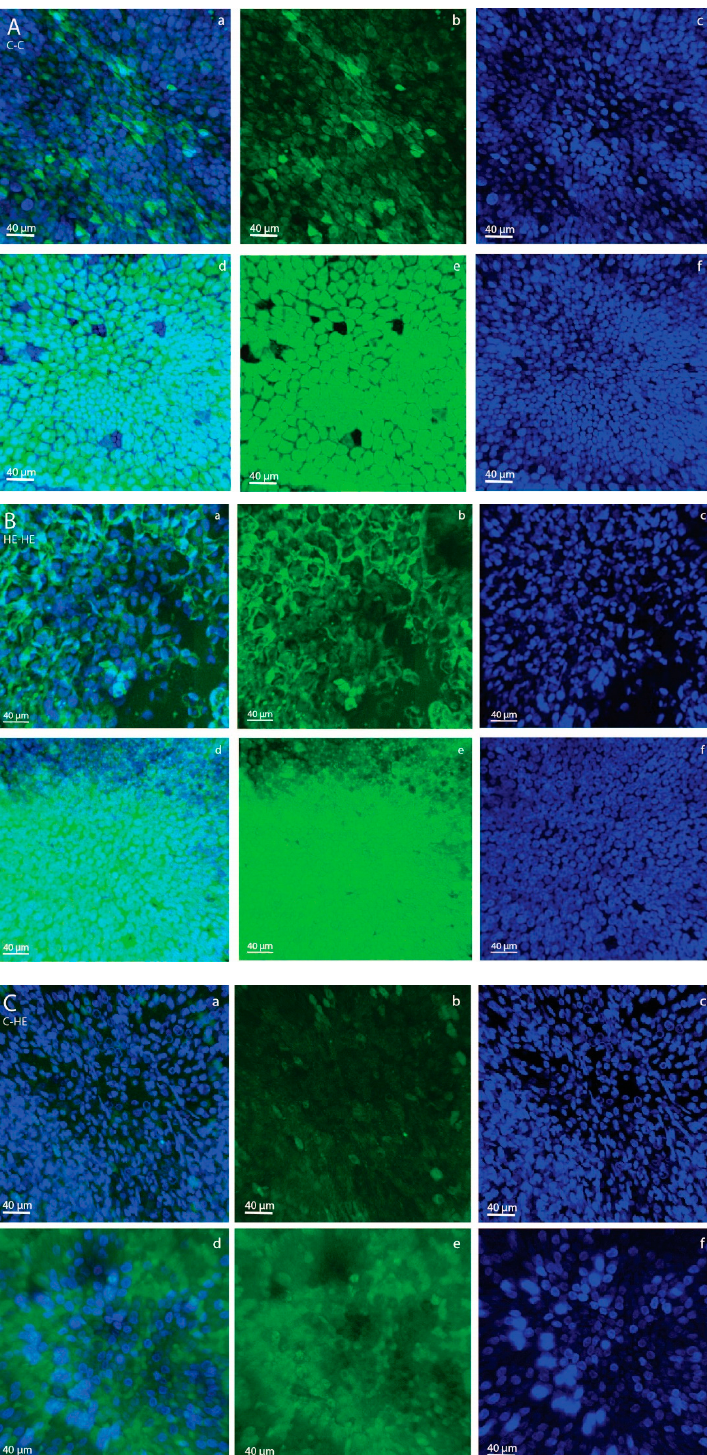
fluorescence, and median fluorescence intensity for 2-NBDG was calculated per sample. For each ET group, a confocal image of a positive YS and a positive AC sample is shown